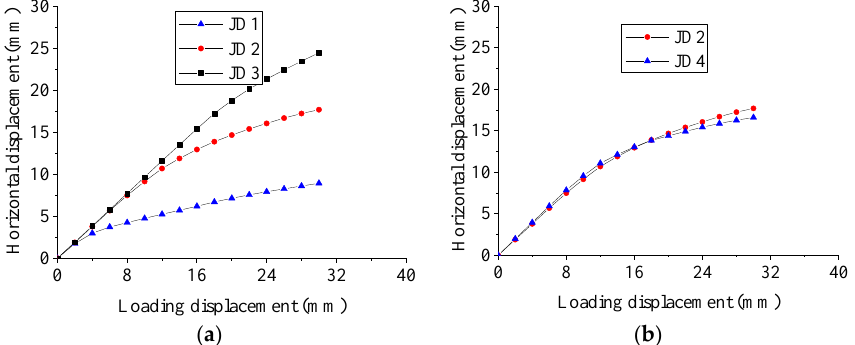
Figure 7. Loading displacement–horizontal displacement curve of semi-fixed dowel joint. ( a ) Thick- ness of rubber sleeve. ( b ) Thickness of rubber pad.